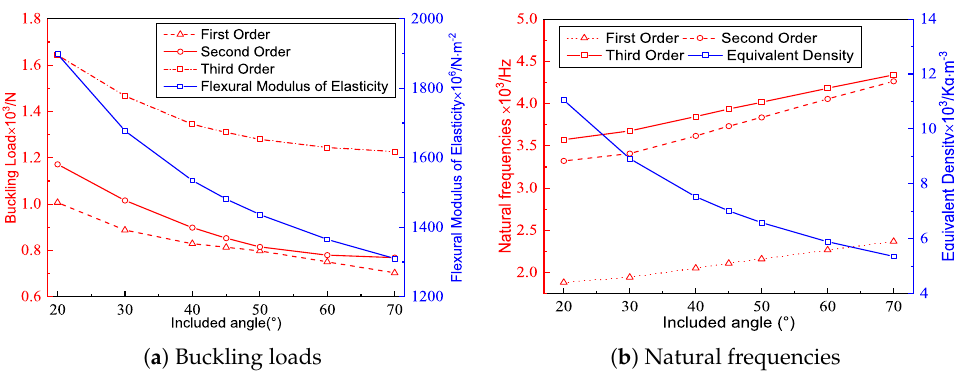
Figure 7. Effects of the included angles on the buckling loads and natural frequencies of the triangular HSP.